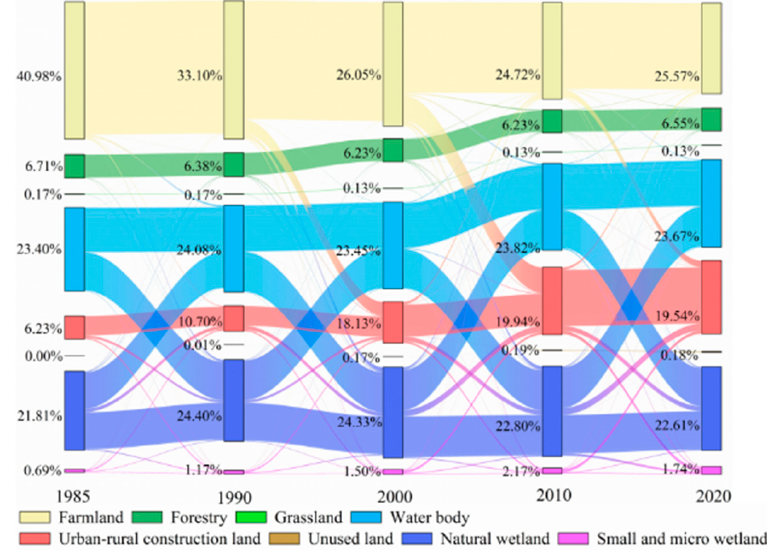
Figure 8. Sankey map of land use changes in Wuxi area from 1985 to 2020.